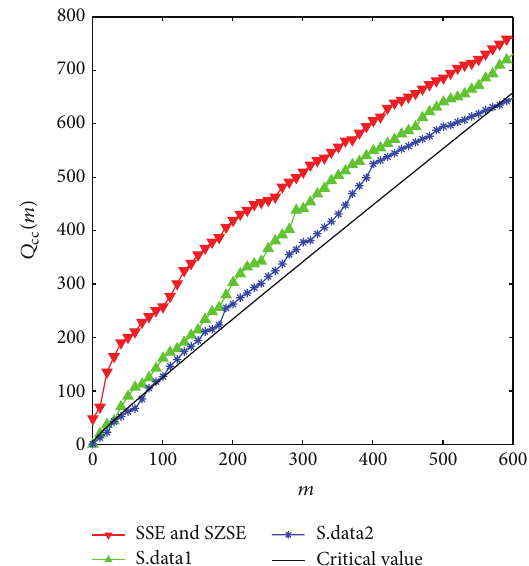
Figure 3: The cross-correlation statistic 𝑄 𝑐𝑐 (𝑚) of return series for the real markets and the financial